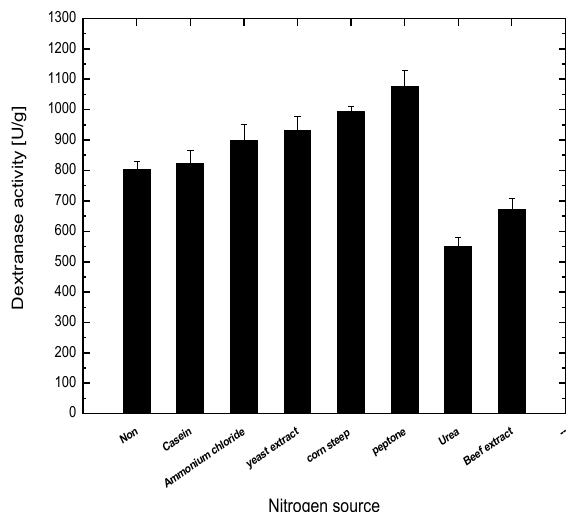
Figure 7. Effect of different nitrogen sources on dextranse production from Bacillus subtilis NRC-B233b .